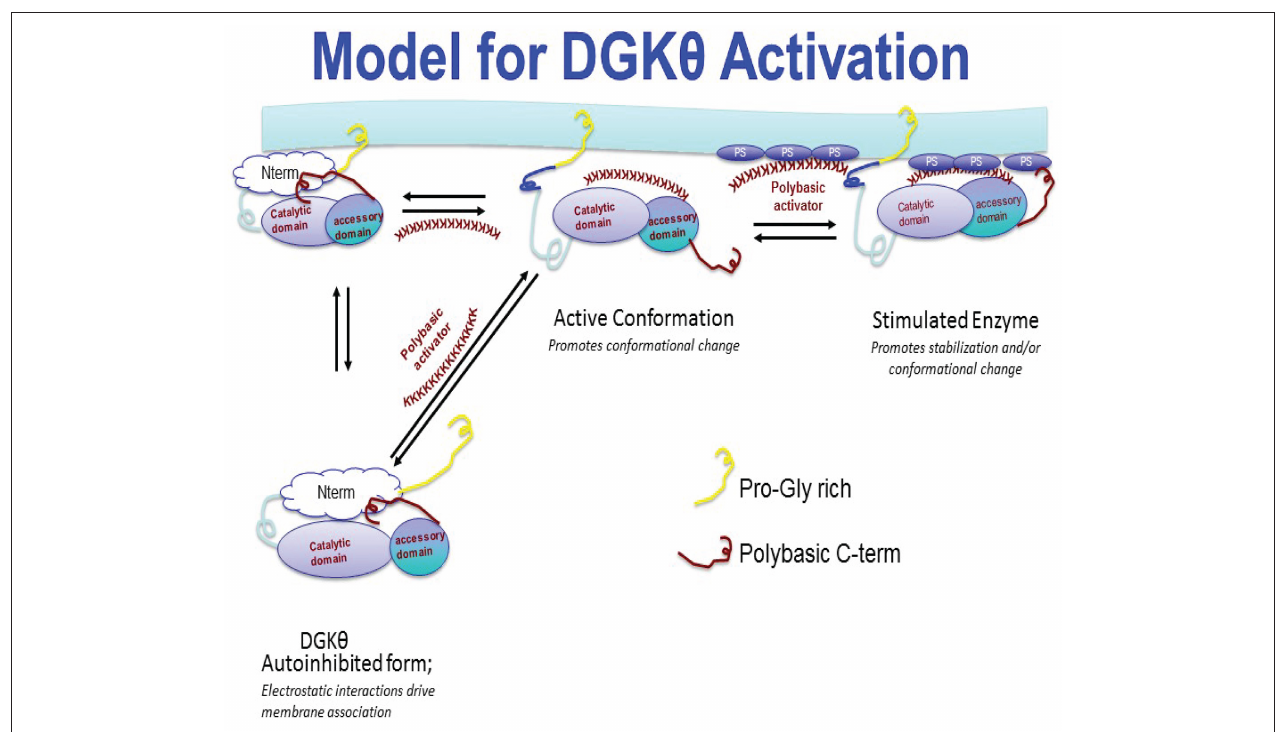
FIGURE 2 | Proposed model for DGK- θ membrane association and activation. In this model, DGK- θ exists in an auto-inhibited state which can bind to membranes in the presence or absence of a protein activator containing a polybasic region. Following membrane binding, full activation is achieved when a triad complex forms composed of enzyme, polybasic protein, and phospholipid